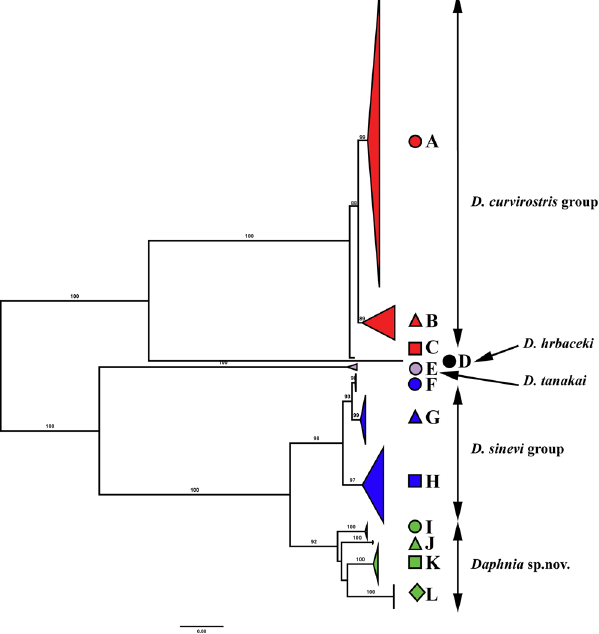
Figure 2. Maximum likelihood tree based on sequences of the mitochondrial ND2 gene representing the diversity among phylogroups of the Daphnia curvirostris group. The support values of individual nodes are based on maximum likelihood. Colors and shapes for main phylogroups correspond to those in Fig.